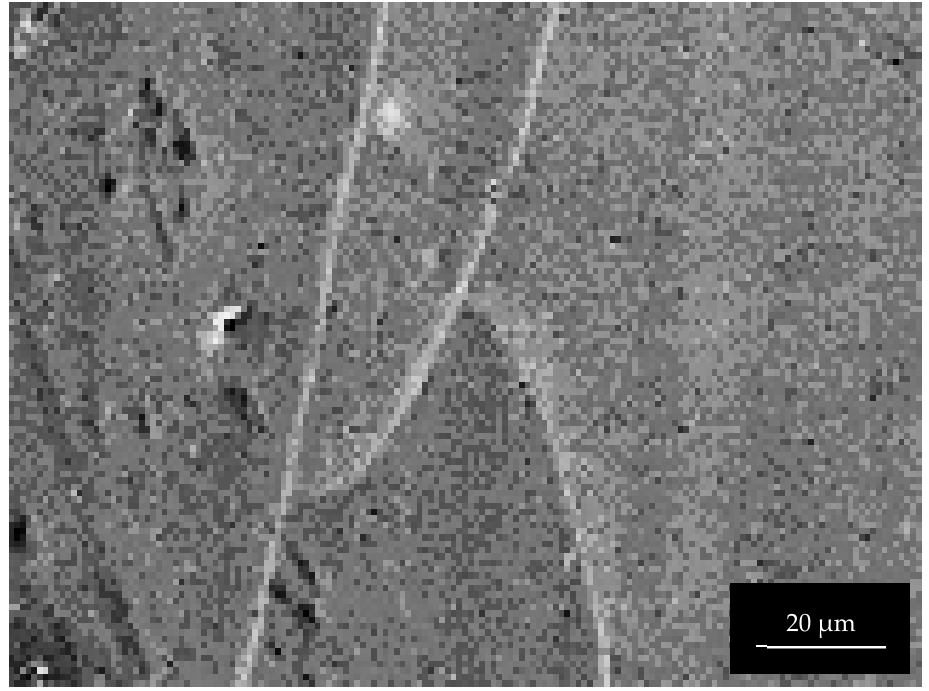
Figure A4. Surface of 3003-Al alloy with t a = 1800 s and t s = 1200 s. Figure 9c was enlarged to 500%.